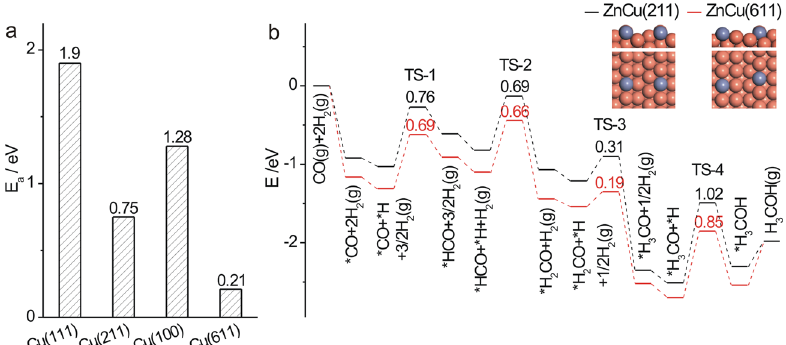
Fig. 8 DFT calculations of CO hydrogenation reaction. a Calculated activation energy for CuZn alloy formation of ZnO on various Cu surfaces and b calculated energy pro fi les of CO hydrogenation into methanol by ZnCu(211) and ZnCu(611) alloys. Insets show the optimized surface structures of ZnCu (211) and ZnCu(611) alloys. The reddish-orange and purple spheres represent Cu and Zn atoms,